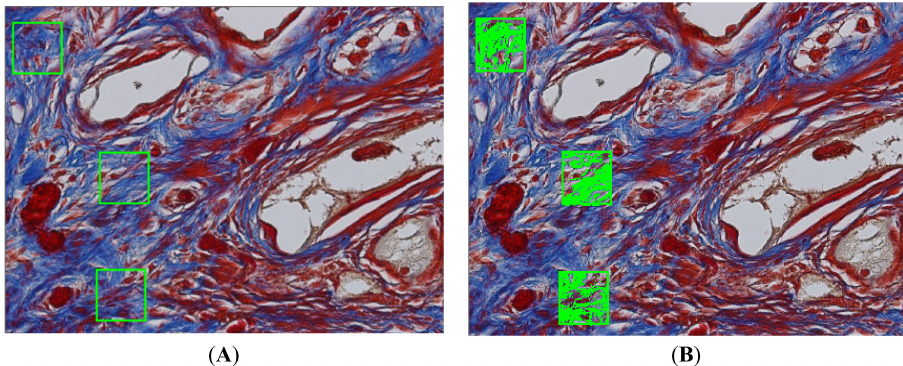
Figure 1. Histomorphometric analysis performed on a Masson’s trichrome stained slide. We can observe in the representative scheme performed by GraphPad Prism Version 8.0 (GraphPad, San Diego, CA, USA), the areas of delimitation chosen ( A ), to measure the percentage of blue coloration representing newly formed matrix ( B